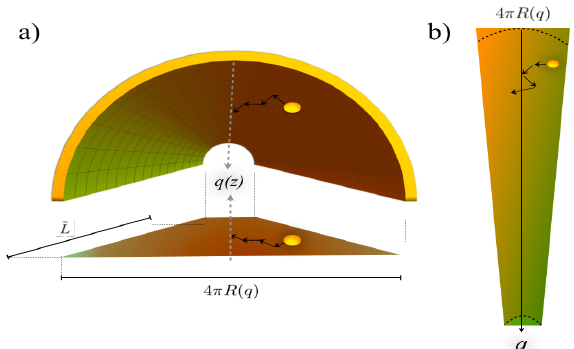
Figure 4. Projection approximation of the diffusion over the surface of a conical pore. ( a ) The effective length q appears due to the projection over the cone. ( b ) The motion along the q coordinate is approximately equal to the motion inside a two-dimensional funnel pore. The semicircular dotted lines indicate the exact form of the surface. For large pores as initially assumed L >> R , the error made by our approximation is negligible.